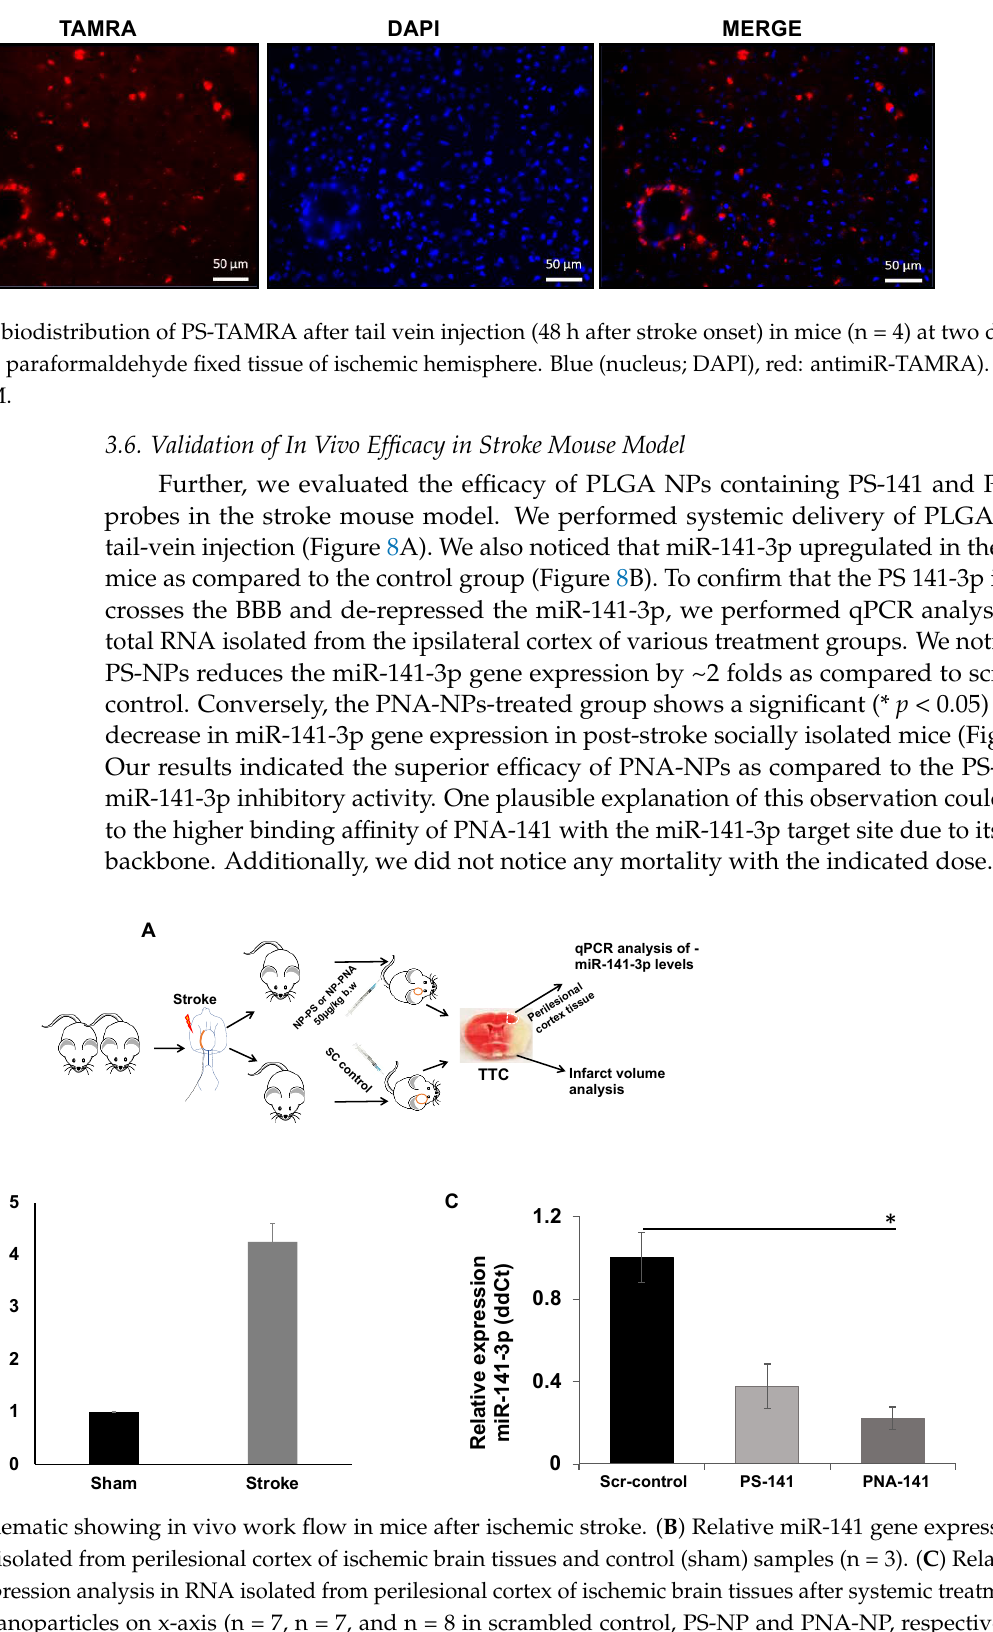
of MCAO onset, we used paraformaldehyde-fixed tissue of the ischemic hemisphere from